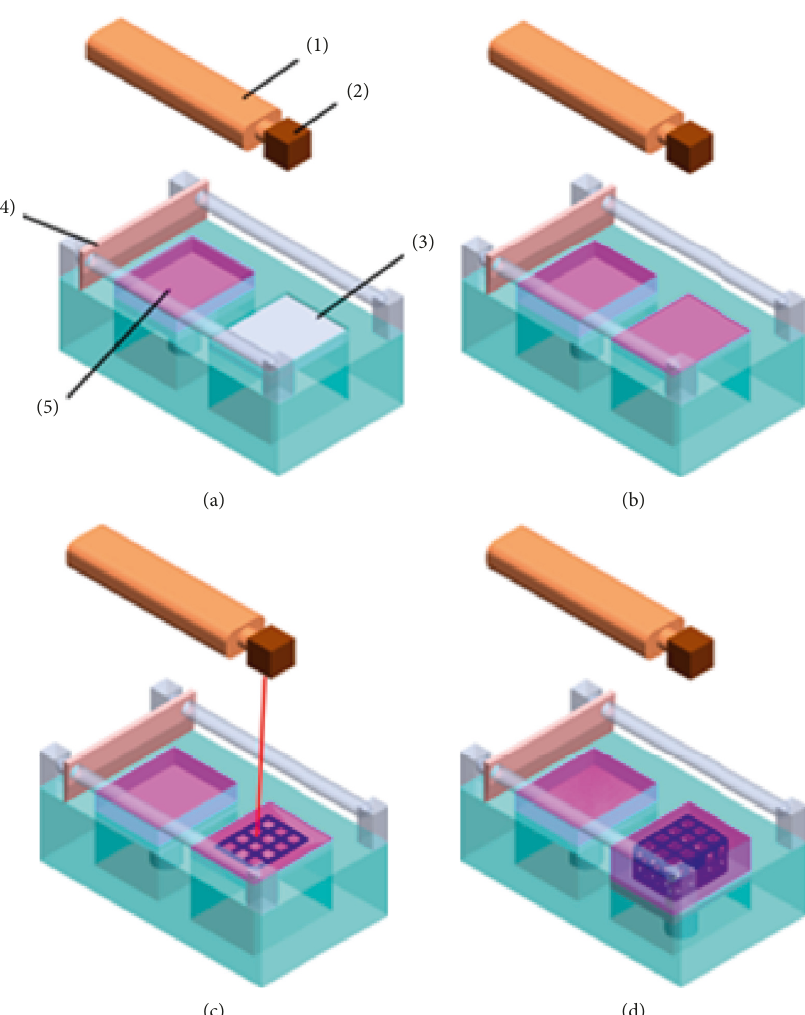
Figure 1: 3D printer assembly and fabrication of the scaffold: (a) servo motor driving: (1) CO (4) scraper, and (5) feeder; (b) paving material; (c) start of 3D printing; (d) end of 3D printing